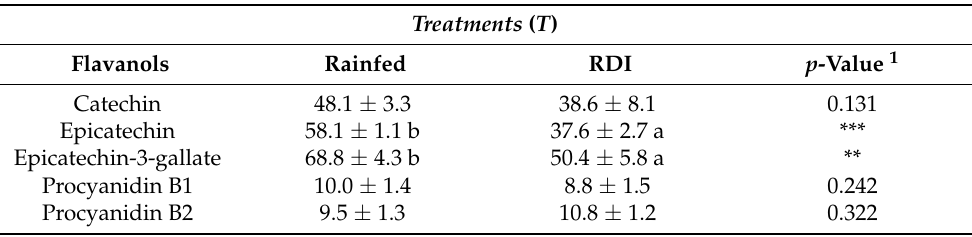
Table 3. Flavanol content (mg/kg) in Monastrell grapes from grapevines under non-irrigated (rainfed) and regulated deficit irrigation (RDI)